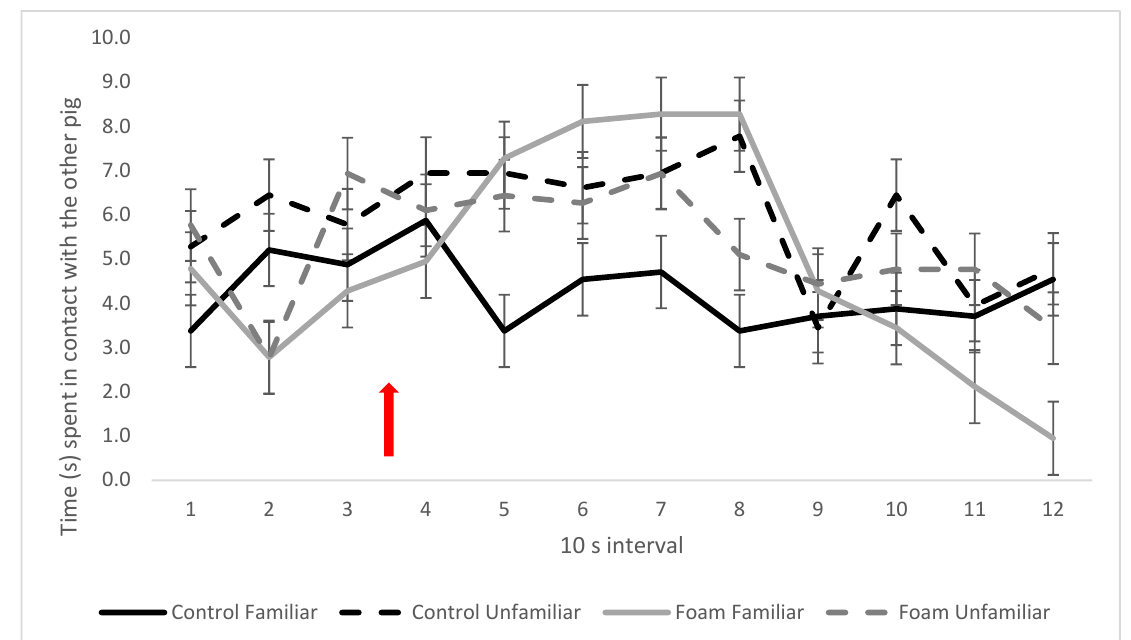
Figure 7. Pig contact, expressed as mean time (s) spent in physical contact with each other per interval in the four pair treatments. Red arrow indicates time of foam start. Values given are LSM ± SE. Lack of overlap of SE error bars indicates significant pairwise difference ( p < 0.05) between treatments or over time between intervals. Overall p -value for the three-way interaction: p <